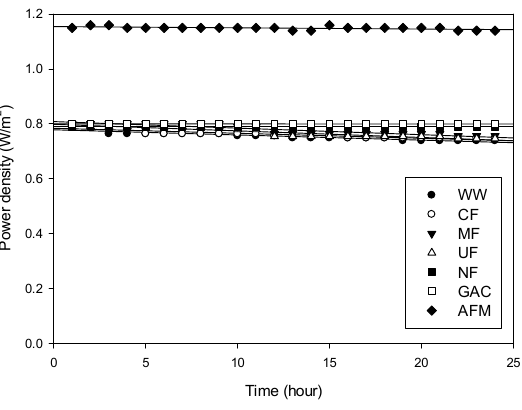
Figure 6. Changes in power density with time for feed solutions with different pretreatments.